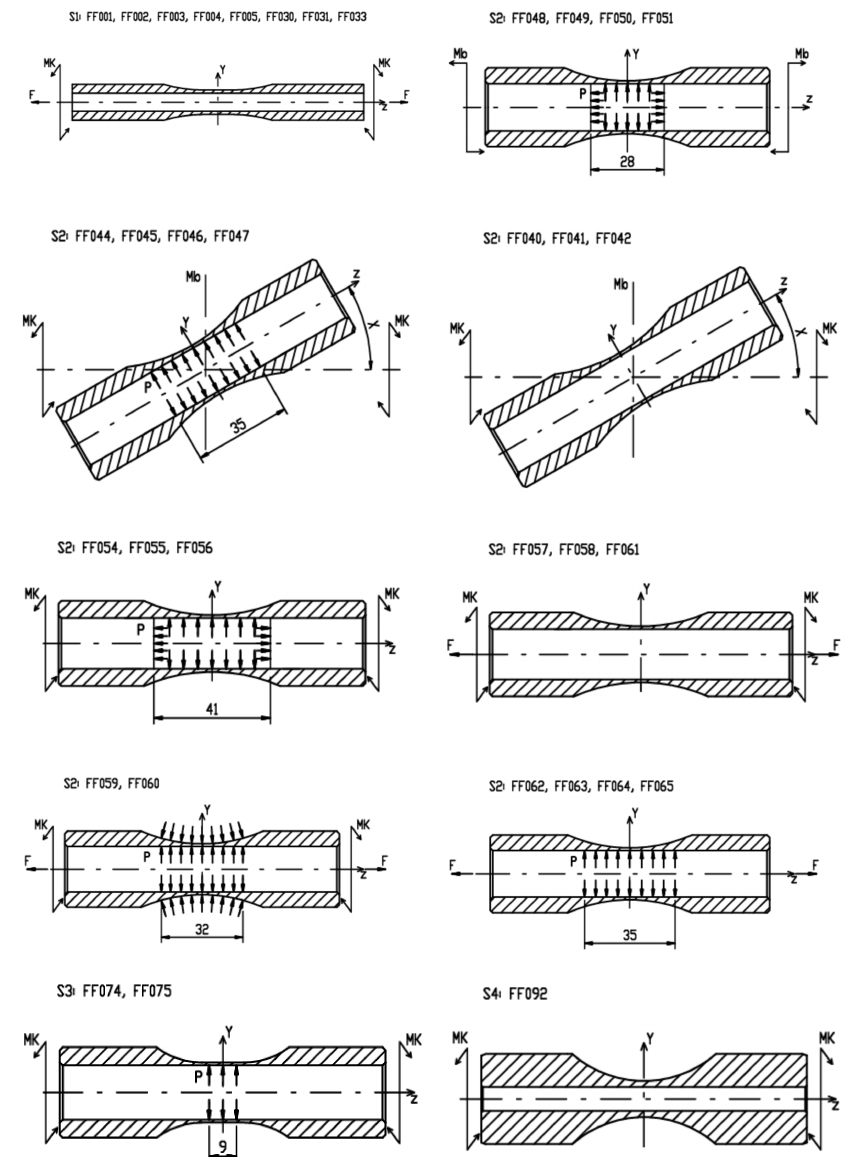
Figure 2. Overview of various setups of experiments. F —push/pull, Mb —bending moment, Mk —torque and P